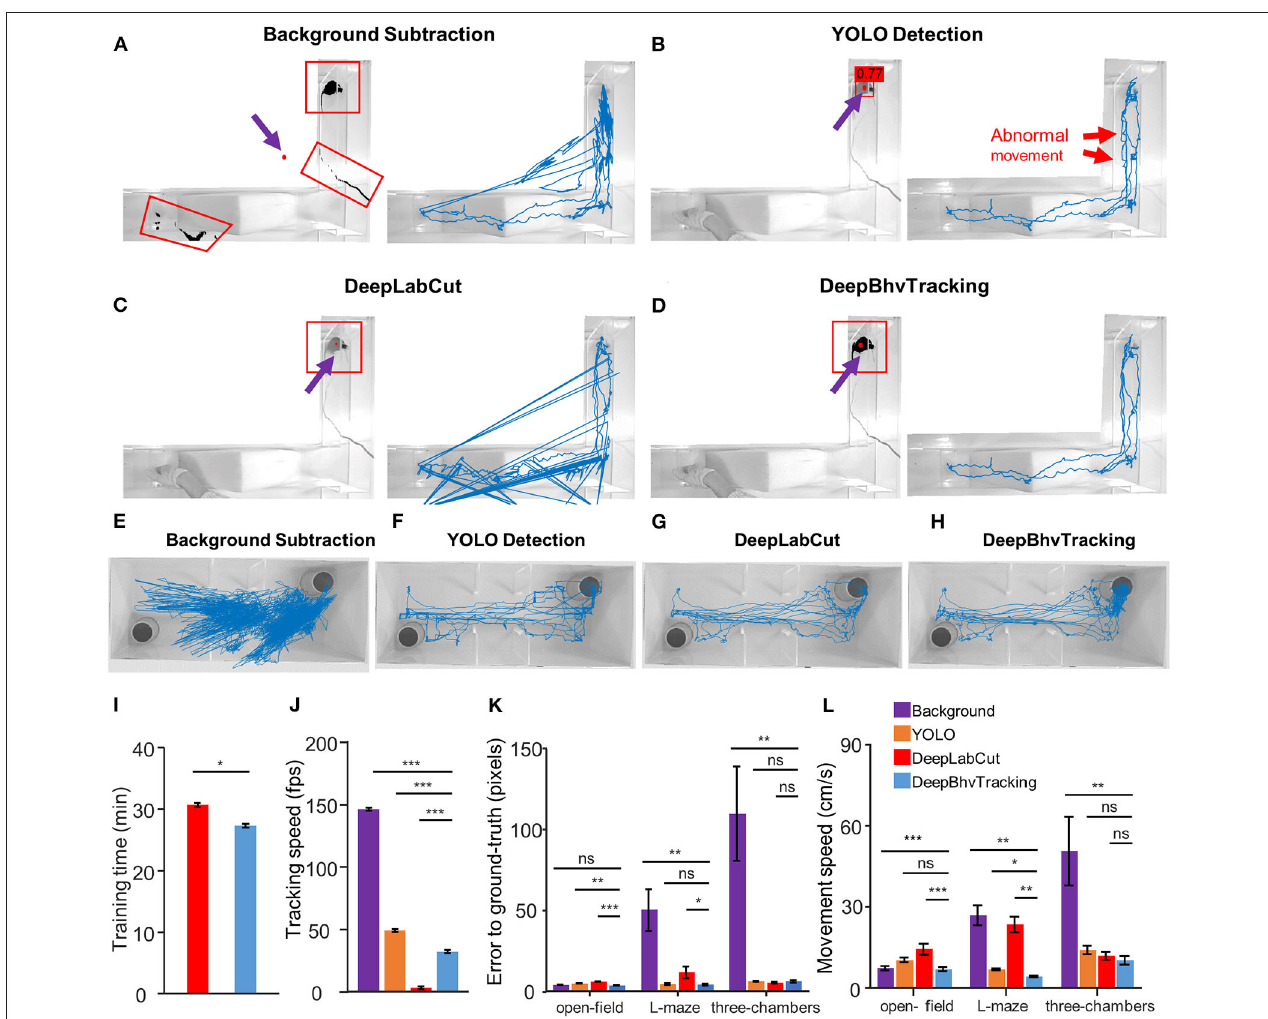
FIGURE 3 | Comparison of three different tracking results for the same video during calcium imaging in a freely behaving mouse. (A) Left: Tracking result of one example image with background subtraction only. Black region in red box indicates the detected pixels. Red dot indicates the center of the target. Due to the similar color between the wire and the target animal, the wire has been detected after removing the background. With this method, the target center is marked outside of the tracking area. Right: Blue line represents the resulting movement trace of a mouse in a 5,000 frame video. (B) Movement trace tracked by YOLO only. There are many abnormal movements (red arrow) in the tracking trace due to the random jumping of the bounding box. The number above the mouse is the p -value predicted by YOLO. (C) Movement trace tracked by DeepLabCut. Three of theframes failed to detect according to the trajectory. (D) Movement trace tracked by DeepBhvTracking. The movement trace is smooth and represents the actual movement of the animal. (E–H) Movement trace in the three-chambered task tracked by background subtraction, YOLO detection, DeepLabCut, and DeepBhvTracking, respectively. (I) Comparison of training time between two algorithms. Both models are trained using the same dataset, pretrained neural network, and parameters. Image number: 300; neural network: resnet50; batch size: 8; iterations: 2,000. (J) Comparison of tracking time of same video between four algorithms. There are significant differences in processing speed between the four tracking methods. (K) Comparison of error to ground truth of four methods in different behavior assays. In these tasks: open field is a simple task without other observable interference; L maze involves wire interference due to the wire cable of free-moving calcium imaging; three-chambered maze involves the condition with a white mouse in bright room light. The sample size for each paradigm is six videos. DeepBhvTracking performed well in all paradigms. The original data are shown in Supplementary Tables 2–4 . * p < 0.05, ** p < 0.01, *** p < 0.001, tested by ANOVA with LSD test. (L) Comparison of movement speed of four methods in different behavior